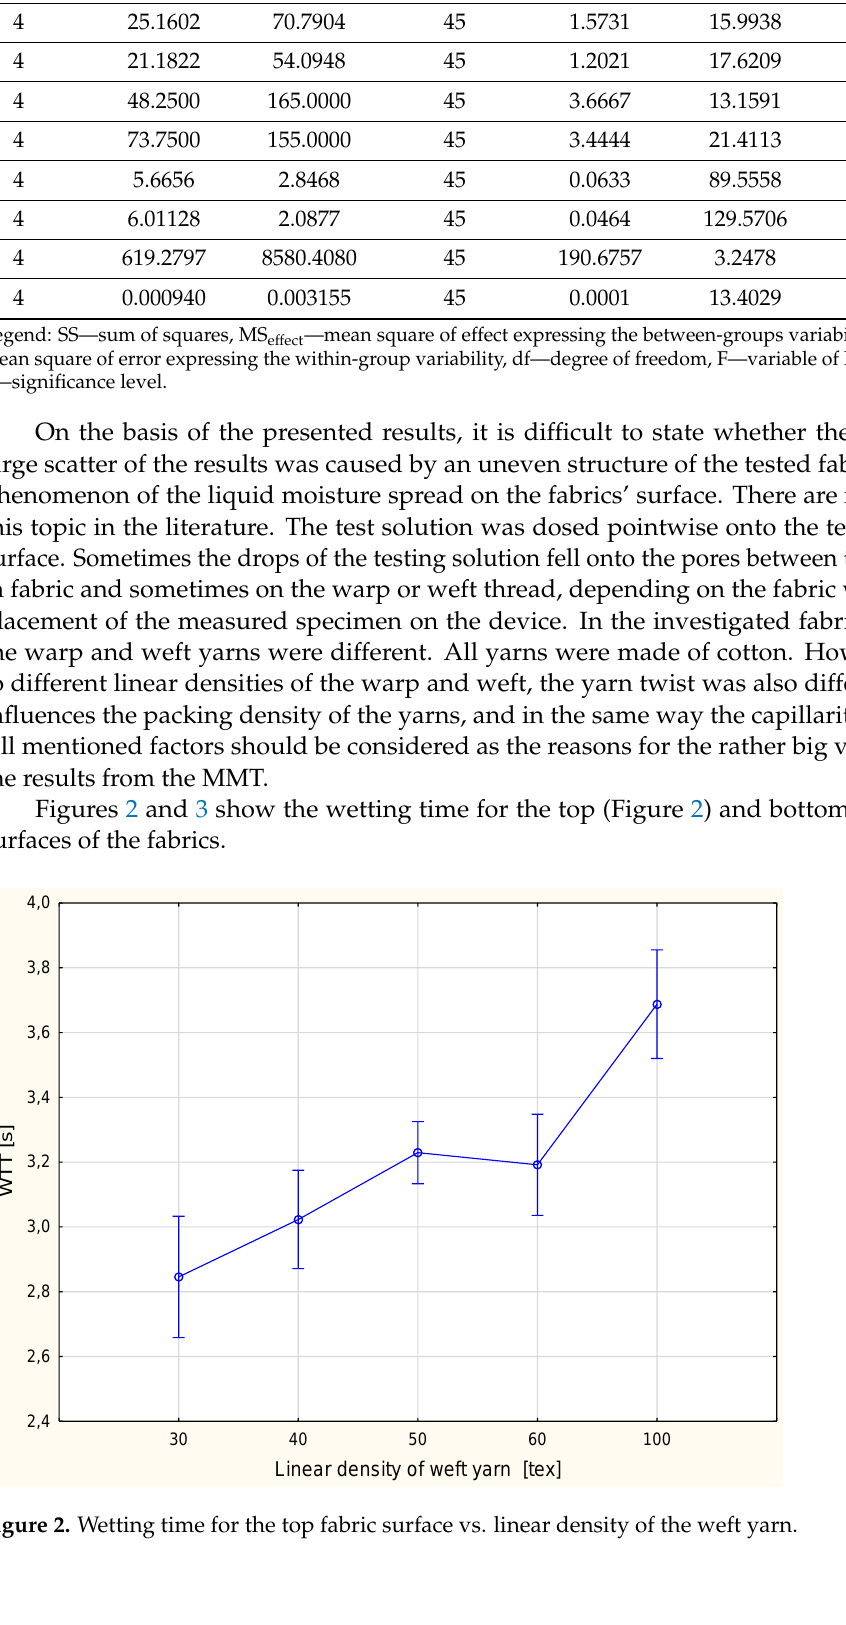
W T B [ s ] Figure 3. Wetting time for the bottom fabric surface vs. linear density of the weft yarn. The WTT and WTB are the time periods in which the top and bottom surfaces of the fabric started to become wet after the test commenced. They are defined as the time in second (s) [33]. The longer the wetting time was, the worse the performance of the fabric from the aspect of wettability. The shortest wetting time was for the fabric variant with the 30 tex weft yarn. For the top surface, the value of the WTT was 2.84 s, and for the bottom surface the WTB was 3.00 s. The longest wetting time for both sides occurred for the fabric variant with the 100 tex weft yarn: the WTT was 3.69 s, and the WTB 3.88 s. It was also found that the wetting time for fabric variants with the weft yarns 50 tex and 60